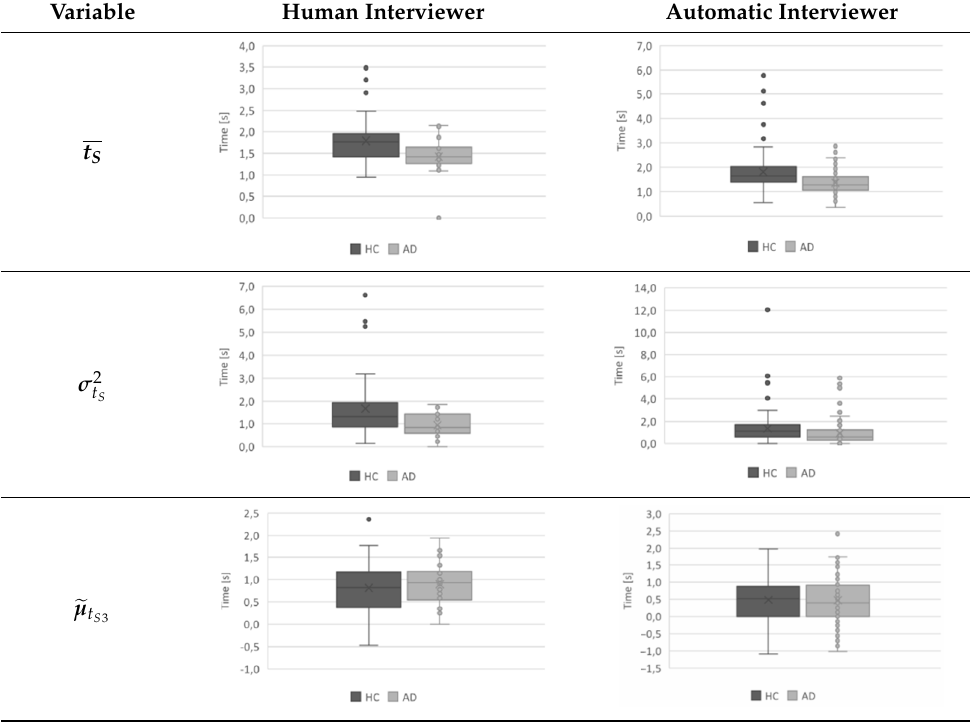
Table 4. Boxplots for the five temporary variables.